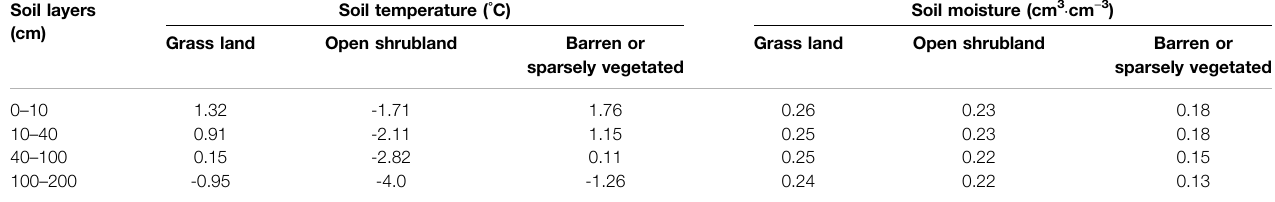
TABLE 3 | Comparison of the annual averaged soil temperature and soil moisture data on different underlying surfaces in Qinghai-Tibet Plateau. Soil layers (cm)